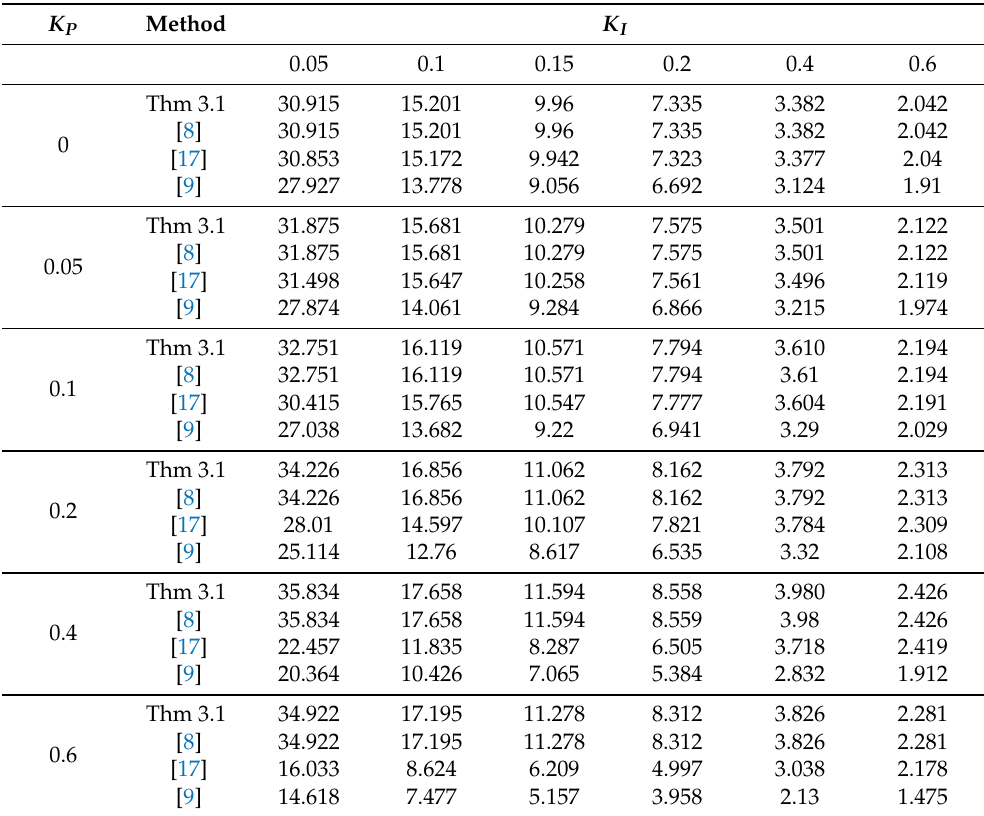
Table 1. Delay margin (single-area LFC